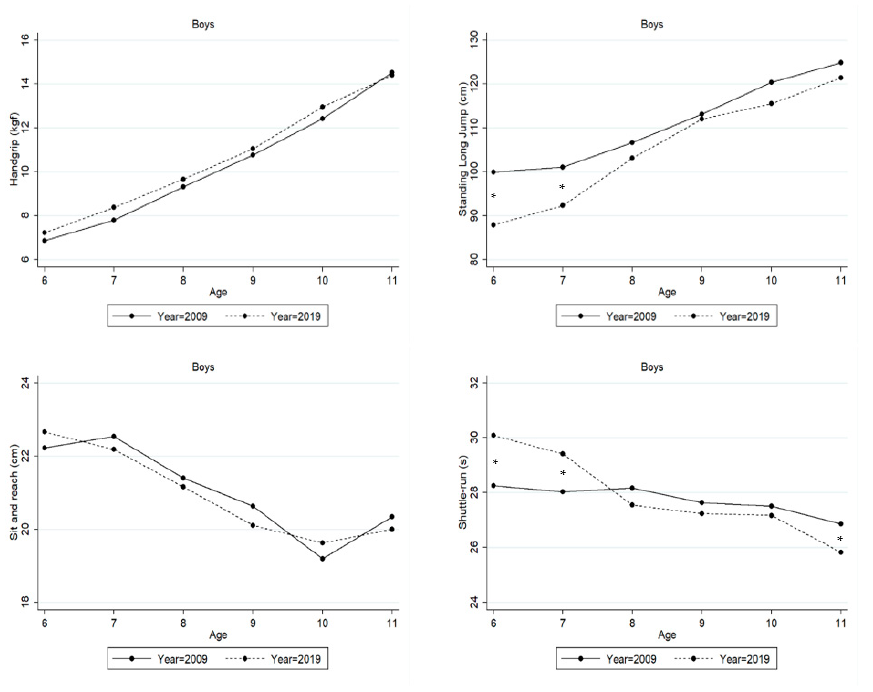
Figure 2. Means of Peruvian boys’ physical fitness between 2009 and 2019. Significant differences are marked by *. Table 4. Descriptive statistics (means ± standard errors), differences (diff) and their corresponding 95% confidence intervals (95%CI) for each physical fitness test in boys between 2009 and 2019 co- horts.